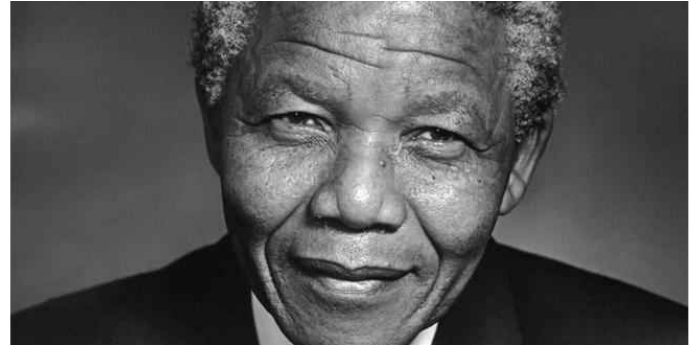
Fig. 1. This JPEG image of Nelson Mandela was stored on 7 December 2013 as P2FKHs spread across multiple transactions, within block 273,536. Size: 14,400 bytes.